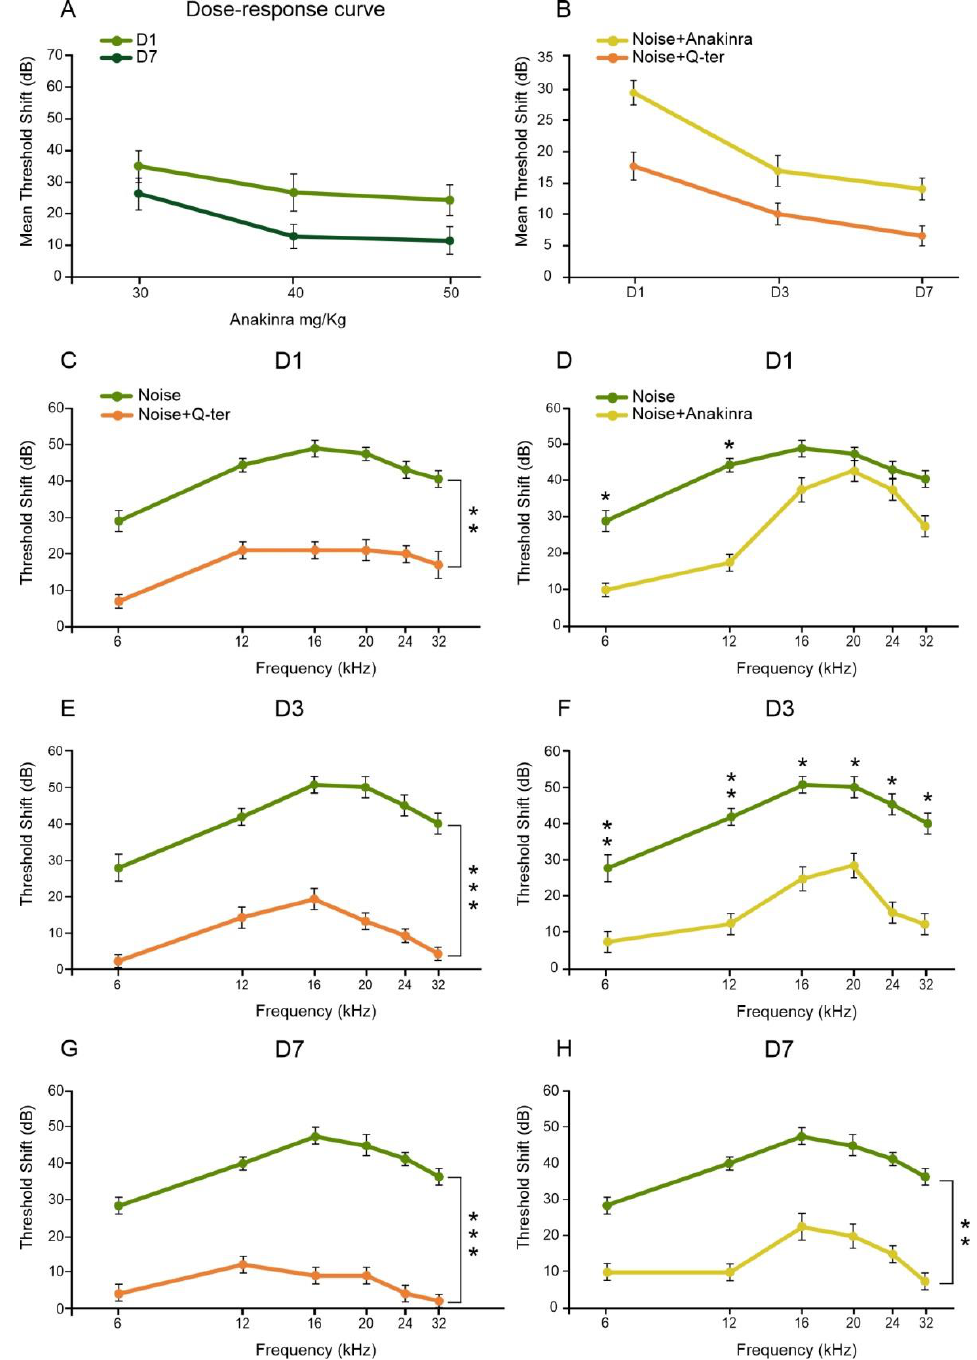
Figure 5. Protective effects of Q-ter or Anakinra treatments against noise-induced hearing loss. ( A ): Dose–response curve showing the best auditory protection obtained with a dosage of 40 mg/kg of Anakinra. ( B ): Mean auditory threshold shift in Noise+Qter and Noise+Anakinra groups measured at 1, 3 and 7 days ( D1 , D3 , D7 ) after trauma. Notably, Q-ter treatment shows an earlier protective effect on hearing function. ( C – H ): Threshold shift values (mean ± SEM) showing the protective effect of Q-ter ( C , E , G ) and Anakinra ( D , F , H ) at different time points after noise exposure. Q-ter attenuates threshold shift by about 20 dB at day 1 (D1) after noise exposure ( C ), about 25 dB at day 3 ( D3 , E ) and about 30 dB at day 7 ( D7 , G ) after noise exposure. The protective effect of Anakinra is delayed with respect to Q-ter; the best protective effect is observed after 7 days from acoustic trauma, with a threshold shift attenuation of about 20 dB ( H ). Asterisks indicate significant differences between groups (* p < 0.05; ** p < 0.01; *** p < 0.001).